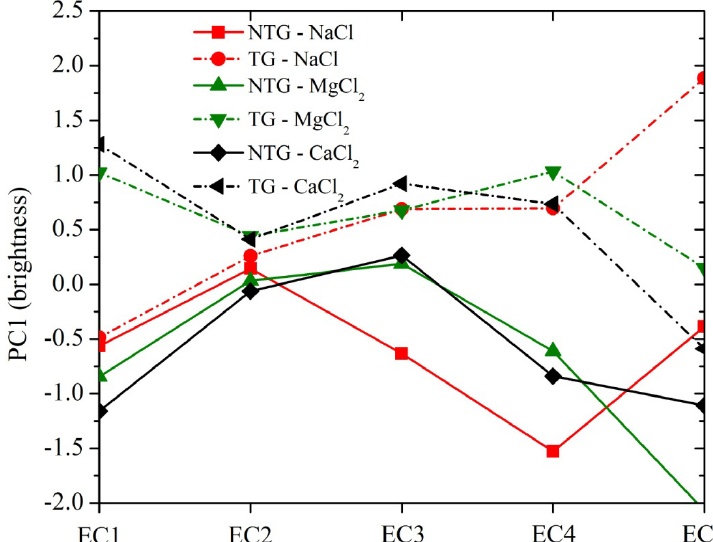
Figure 6. Projection of average PC1 scores for untreated (NTG) and treated (TG) soil samples with gypsum, as a function of the five classes of electrical conductivity (EC) of the saline solutions used to irrigate the